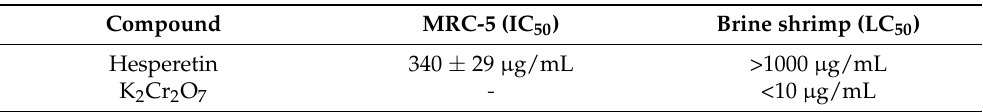
Table 3. Cytotoxicity/toxicity of hesperetin observed towards MRC-5 cells in vitro and brine shrimps in vivo ( µ